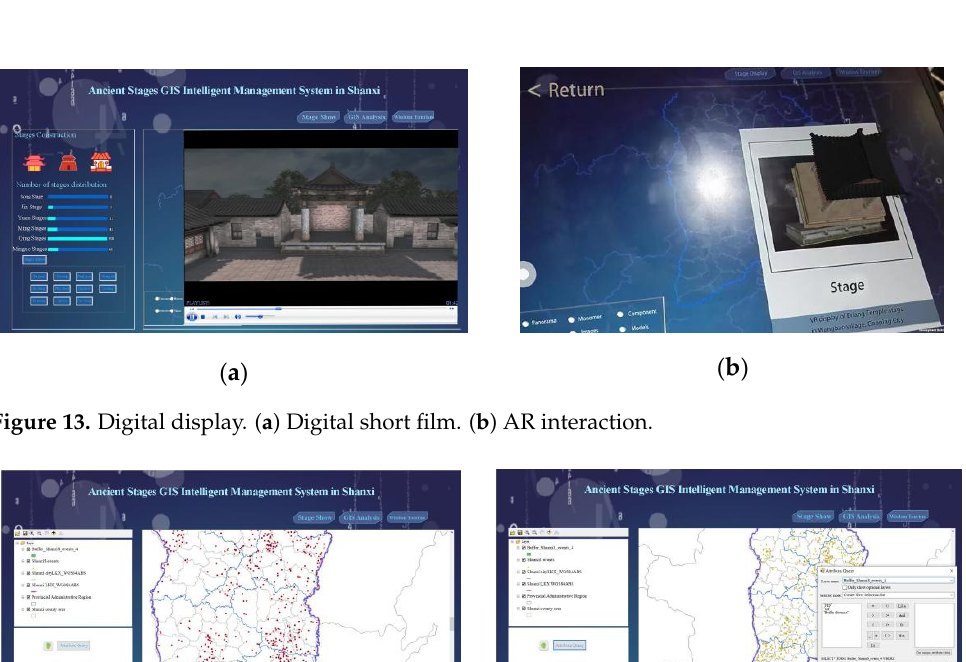
Figure 12. Stage introduction. ( a ) Browse briefly. ( b ) Explain details in interaction.